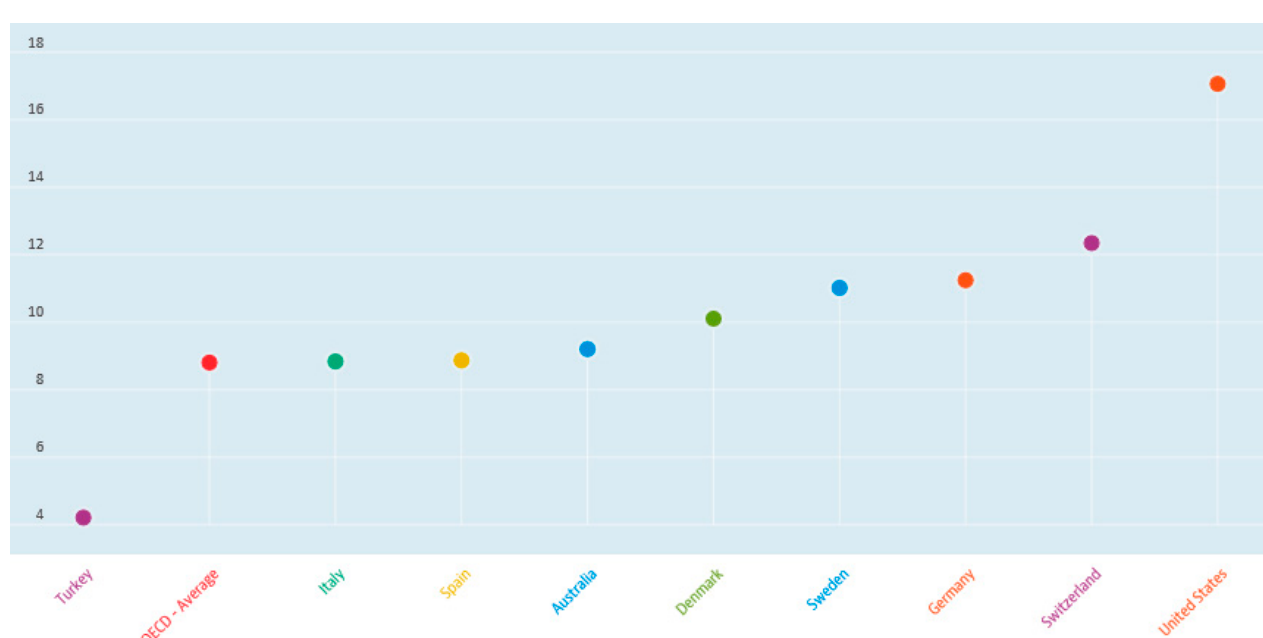
Figure 3. Per cent of gross domestic product (GDP) healthcare spending by country.